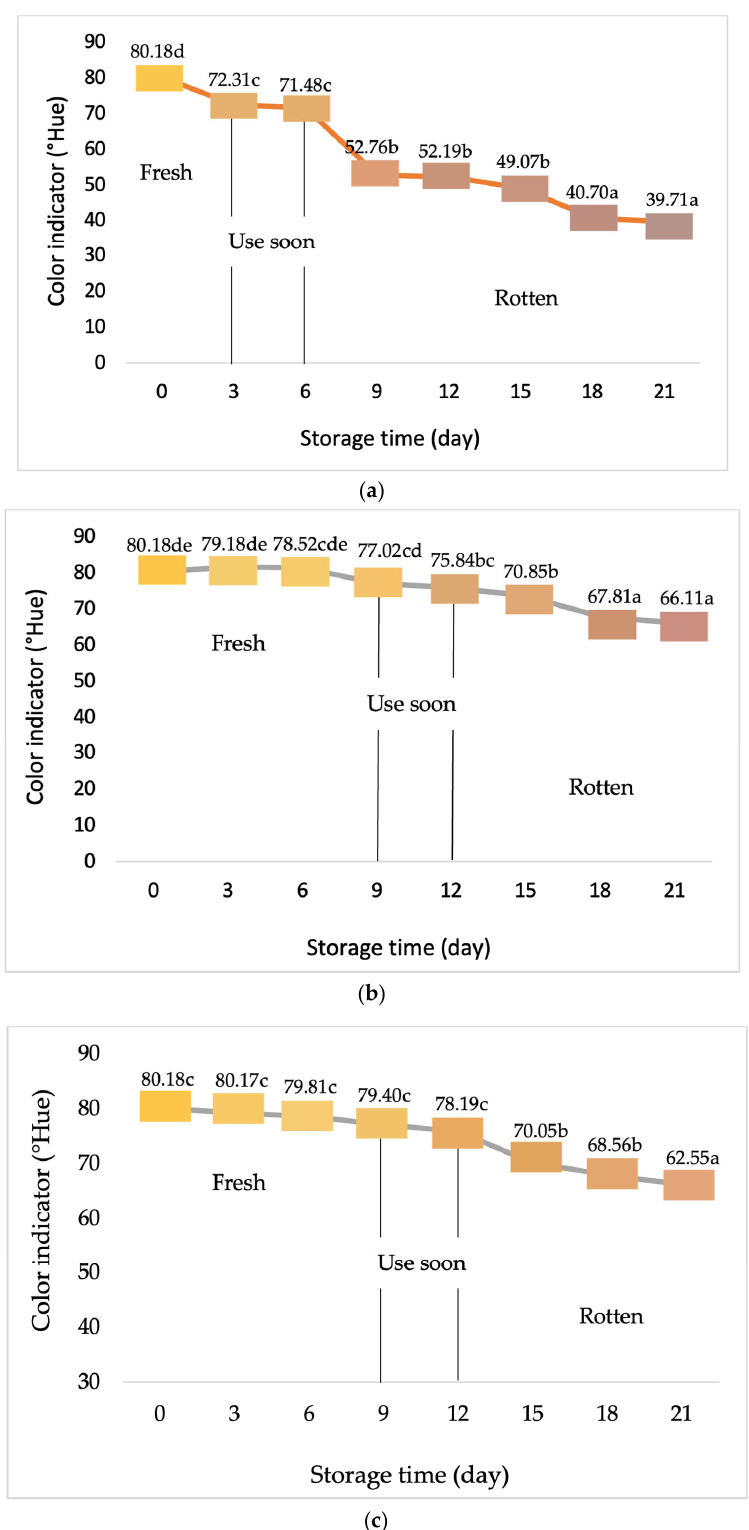
Figure 3. Color change profile of intelligent indicator labels with garlic extract addition on the concentrations at 0% ( a ), 15% ( b ), and 20% ( c ). The mean value followed by different letters showed a significant difference based on the Duncan’s test at the 5% level ( p -value < 0.05). Phase I with dark yellow indicating fresh, phase II with yellow and red gradations indicating have to be consumed soon, and phase III with faded red indicating rotten meat.